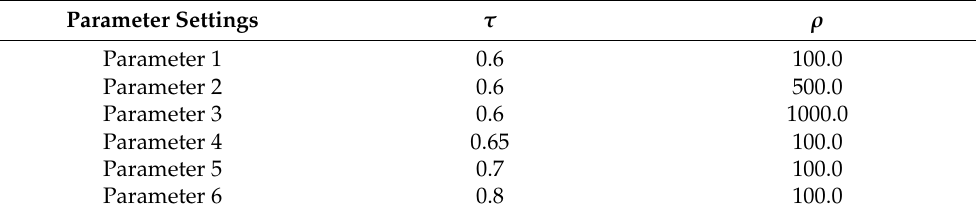
Figure 11. The influence of different parameter settings on DCNG model in KAT data set. Table 7. Different parameter settings on KAT data